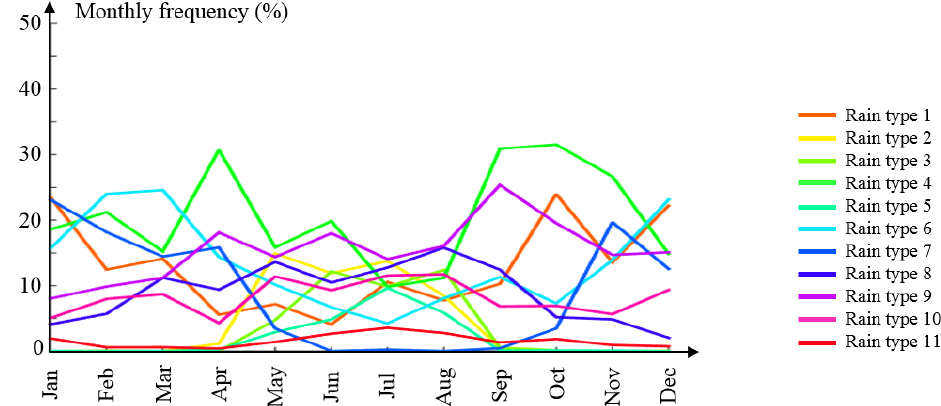
Figure 8. Monthly occurrence of rain types during the year 2017.